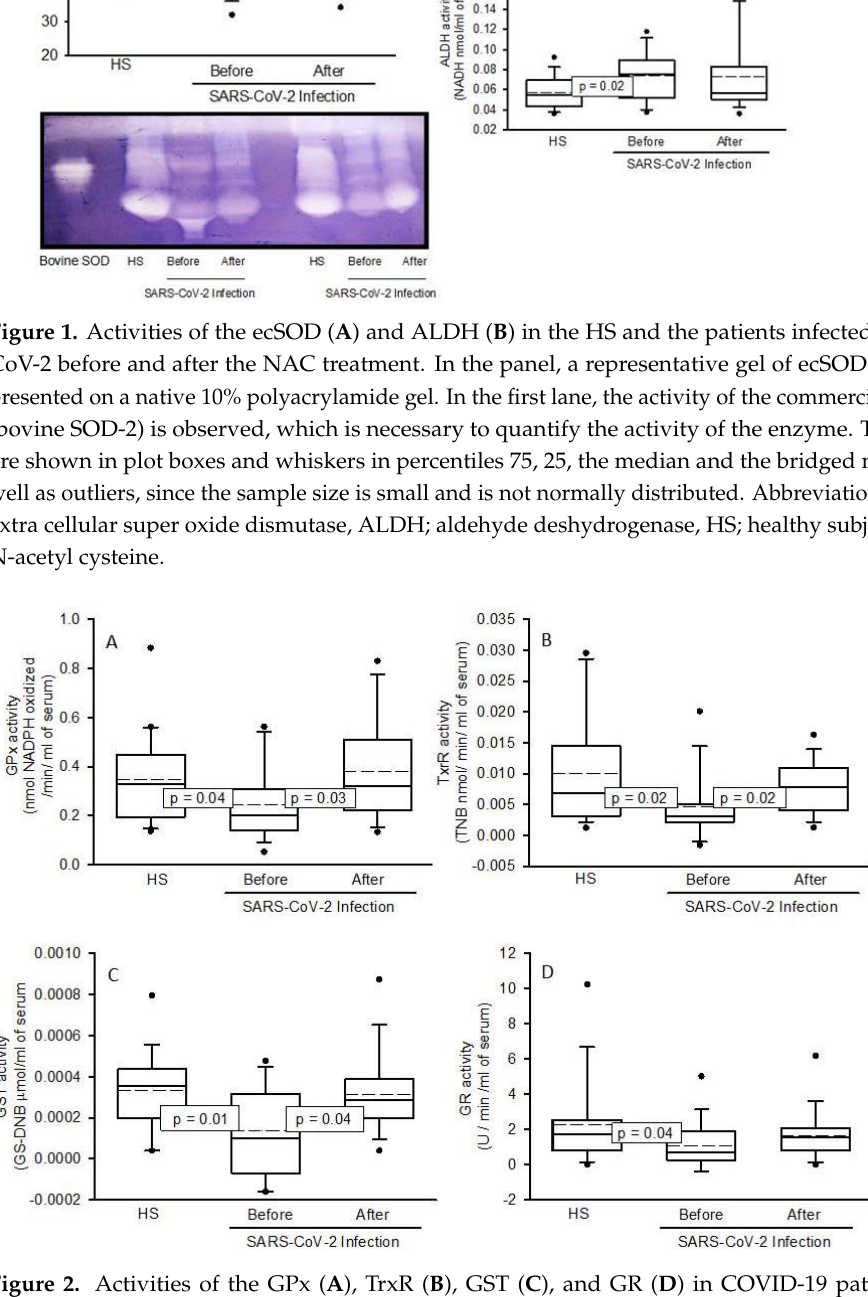
Figure 2. Activities of the GPx ( A ), TrxR ( B ), GST ( C ), and GR ( D ) in COVID-19 patients with the NAC treatment. The results are shown in plot boxes and whiskers in percentiles 75, 25, the median and the bridged midline, as well as outliers, since the sample size is small and is not normally distributed. Abbreviations: GPx = glutathione peroxidase, TrxR = thioredoxin reductase, GST = glutathione-S-transferase, GR = glutathione reductase, HS; healthy subjects, NAC; N-acetyl